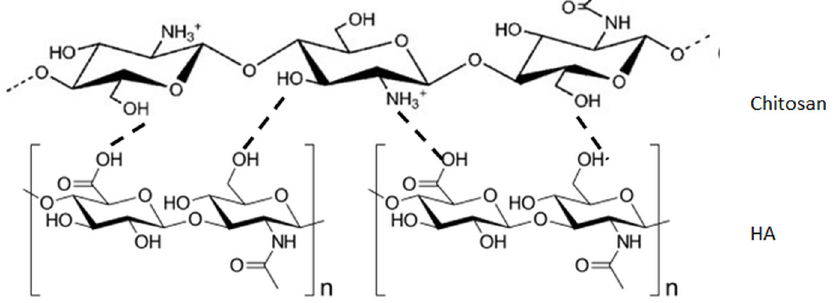
Figure 3. Possible interactions between chitosan and hyaluronic acid (HA) in blends.